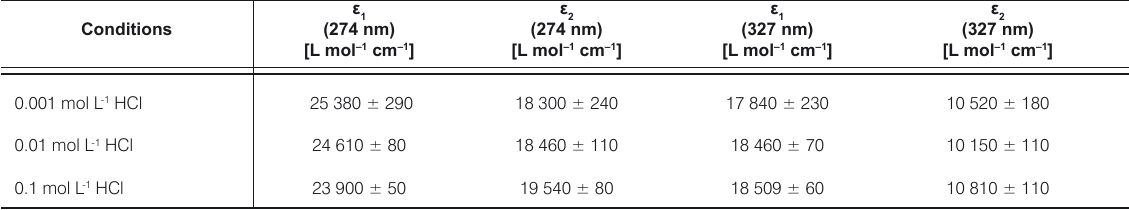
) and pseudobase ( ε 1